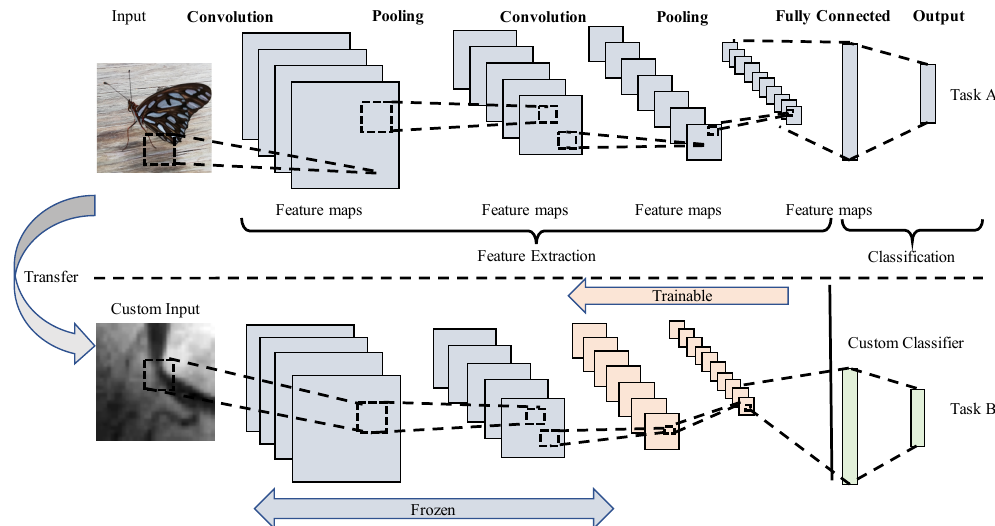
Figure 5. Transfer learning scheme. The last fully-connected layers are replaced with custom layers for the proposed problem. The fine-tuning is carried out in the top-level layers, while the rest of the transfer networks remains temporarily idle or frozen (i.e., the weights stay unchanged during the optimization